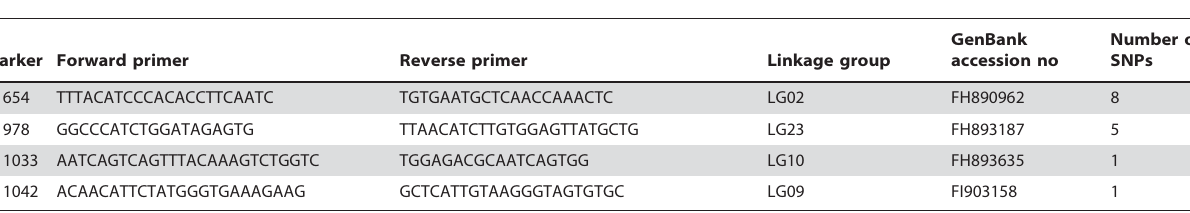
Table 1. Primer sequences.